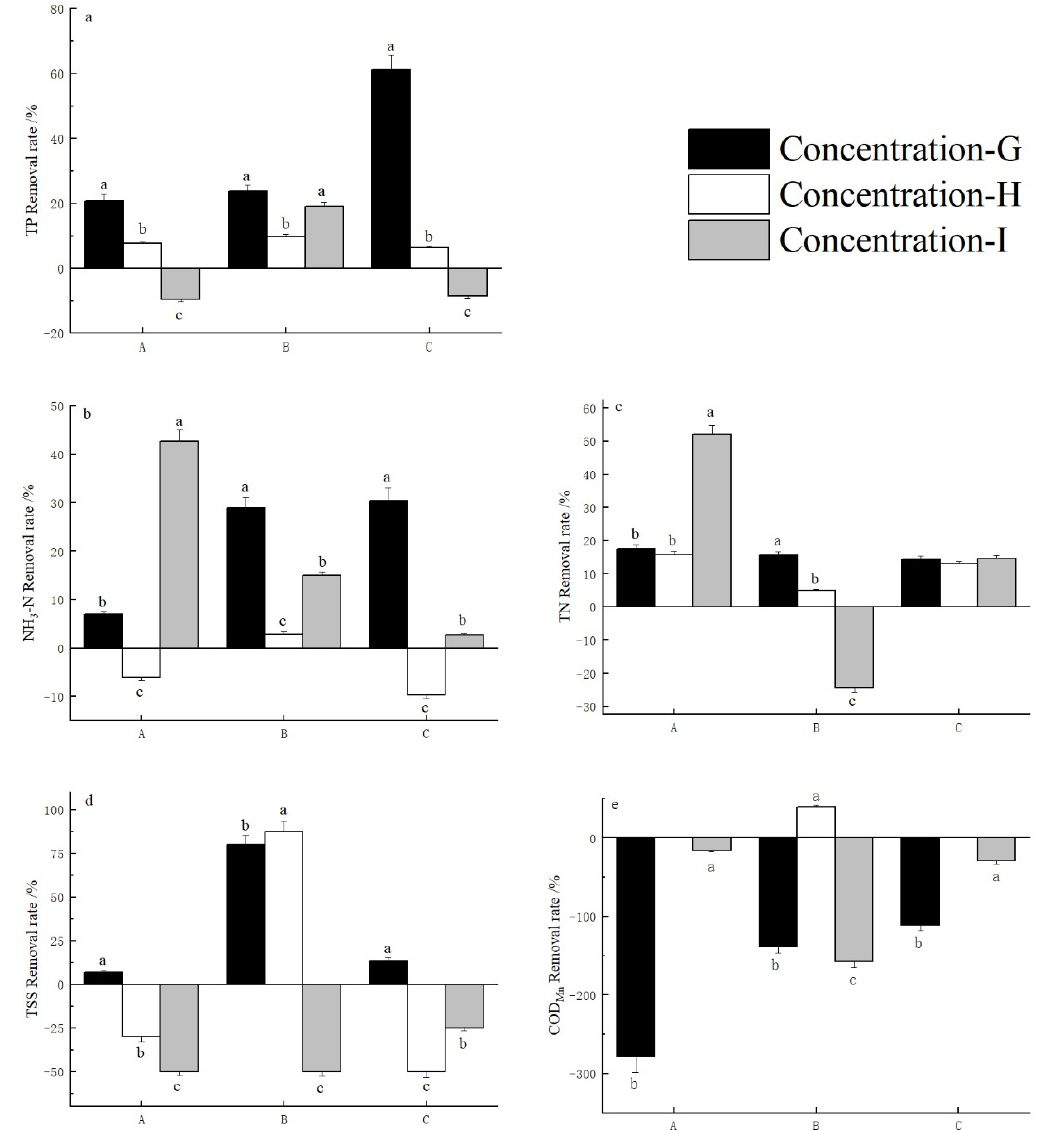
Figure 3. Removal rate of wastewater from three pollution concentration loads in the treatment unit.